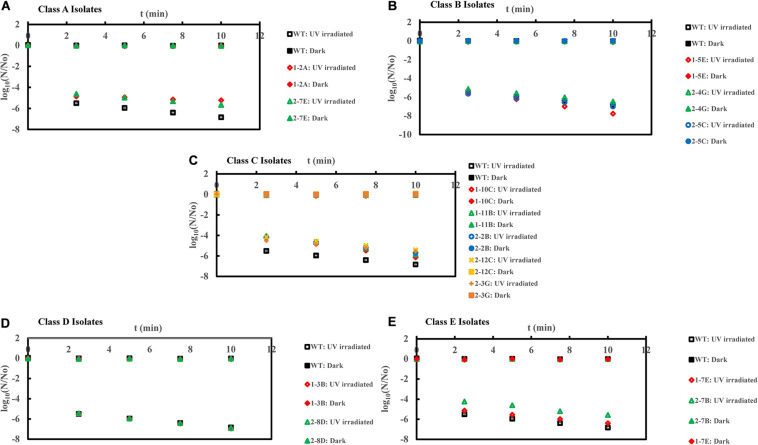
Inactivation curves of E. coli PI-7 WT and 5 categories of PI-7 transposon mutants exposed to UV irradiation in buffer. UV-based inactivation did not follow first order kinetics and hence, best-fit curves are not plotted as well as half-lives are not calculated. UV inactivation is expressed in terms of time required to achieve a certain log reduction. (A) Inactivation curves of PI-7 WT and resistant isolates (Class A isolates) exposed to UV; (B) Inactivation curves of PI-7 WT and susceptible isolates (Class B isolates) exposed to UV; (C) Inactivation curves of PI-7 WT and isolates with enhanced virulence (Class C isolates) exposed to UV (D) Inactivation curves of PI-7 WT and isolates with enhanced oxidative stress response (Class D isolates) exposed to UV; (E) Inactivation curves of PI-7 WT and isolates with enhanced motility and siderophore production (Class E) exposed to UV.